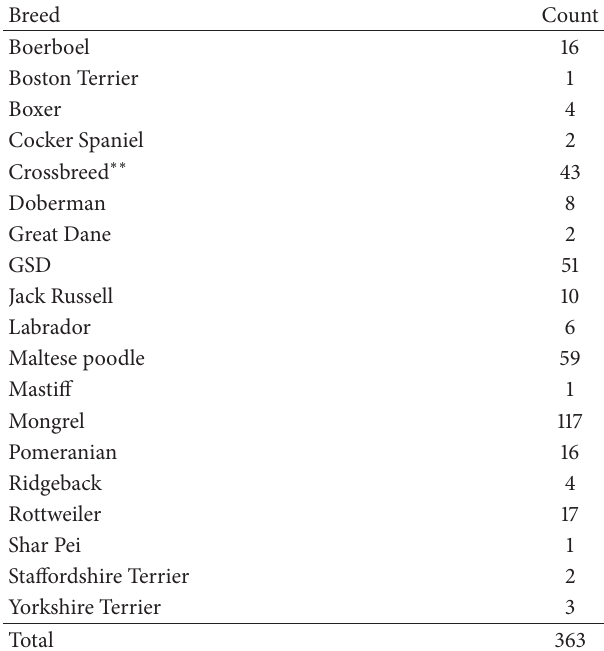
Table 1: Distribution of breeds of dogs included in this study. Breed